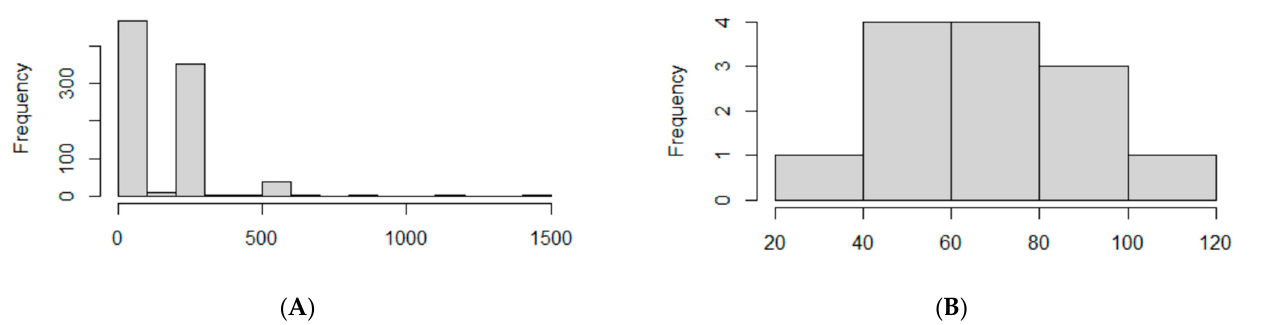
Figure 5. The bar graph represents the size distribution of missing sites for ( A ) nanopore and ( B ) Illumina samples. The X -axis represents the size of missing sites; Y -axis represents the absolute frequency (number) of missing sites per size. Table 2. Comparison of the PANGO lineage and GISAID clade assignment for consensus sequences produced with Oxford Nanopore Technologies and